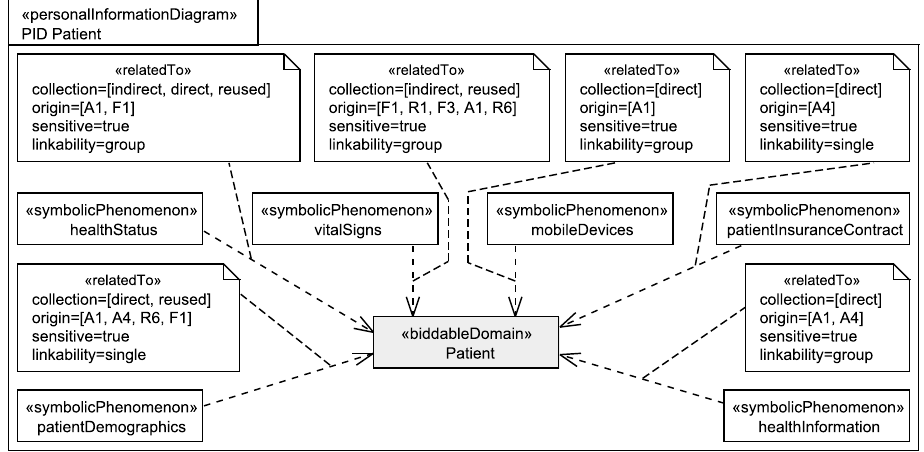
Figure 6. Personal information diagram for the stakeholder patient after the step Identification of Personal